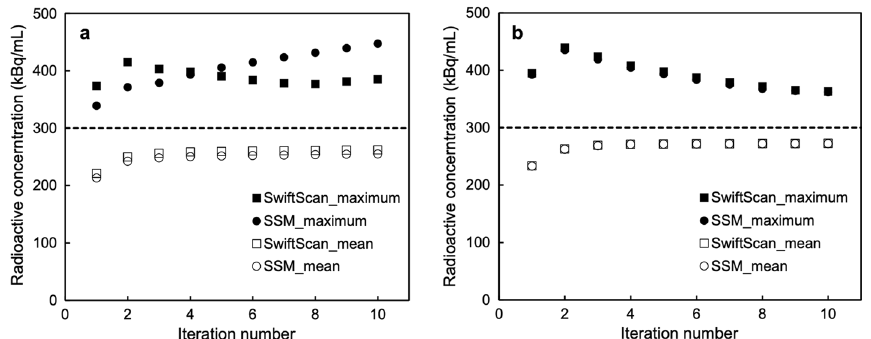
Fig. 3 Effects of increasing the number of iterations of reconstruction (with 10 subsets). Effects on a short-time (5 min) acquisitions and b longtime (32 min) acquisitions. The filled and unfilled squares indicate the maximum and mean radioactivity concentrations of SwiftScan SPECT, respectively. The filled and unfilled circles indicate the maximum and mean radioactivity concentrations of step and shoot mode (SSM), respectively. The dashed line indicates the actual concentration of radioactivity